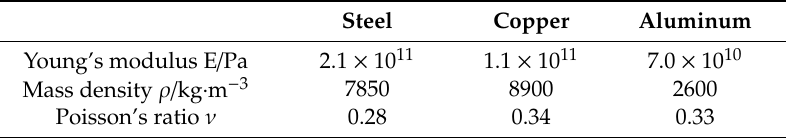
Table 2. The parameters of the beam and spring-mass oscillator.